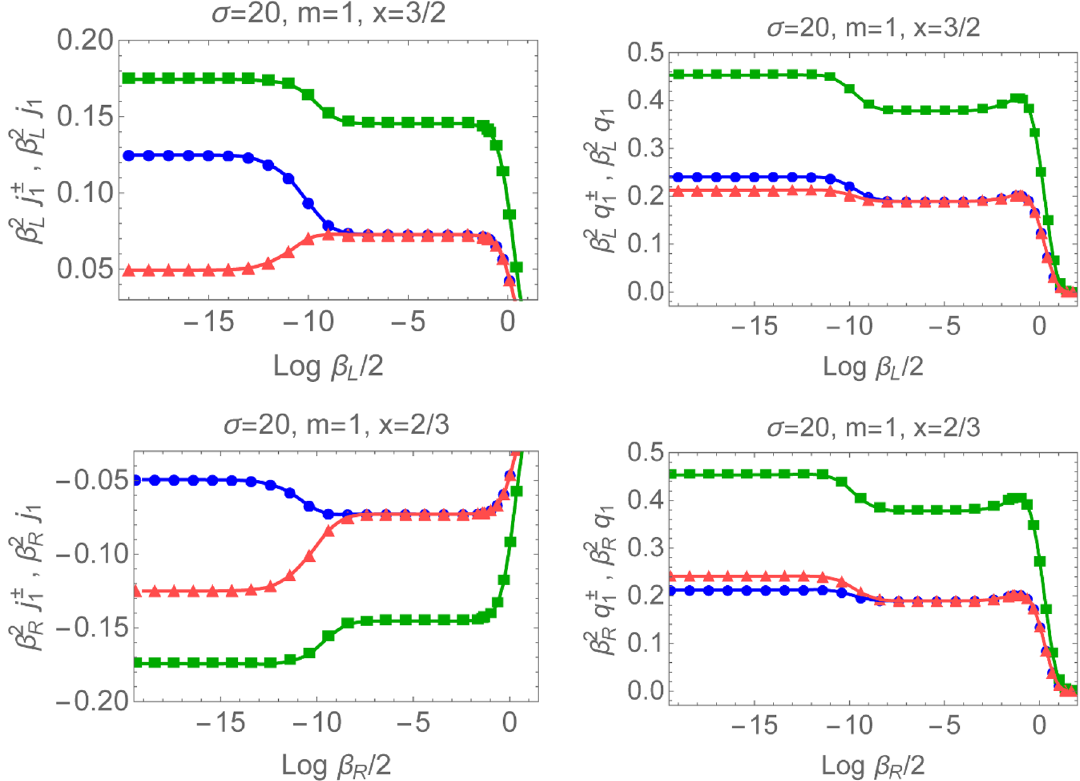
Figure 7 . The total (scaled) energy current (cid:12) 2 red) and (cid:12) 2 (circles, blue) and similarly for the energy density. We consider the cases x = 3 = 2 j (cid:0) i 1 ( i = L ) and x = 2 = 3 ( i = R ). In all cases (cid:27) = 20 ; m =